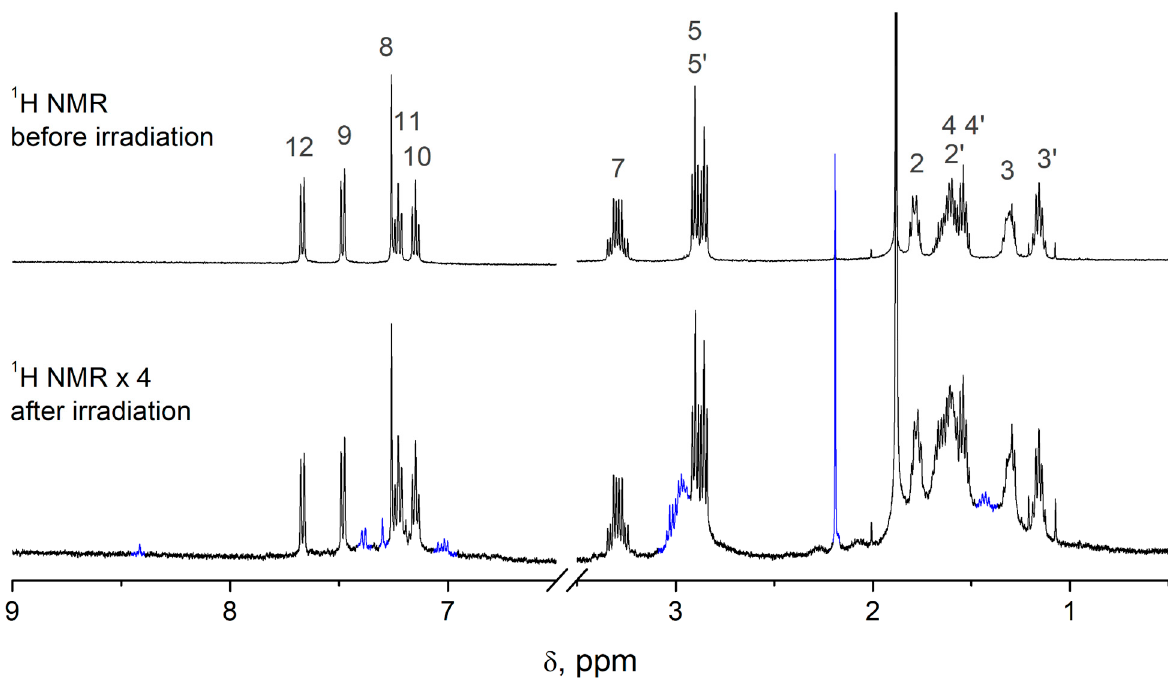
Figure 3. 500 MHz 1 H NMR spectra of 3 mM solution of peptide III before and after photolysis in water-d 2 ; photolysis products are marked by blue color.